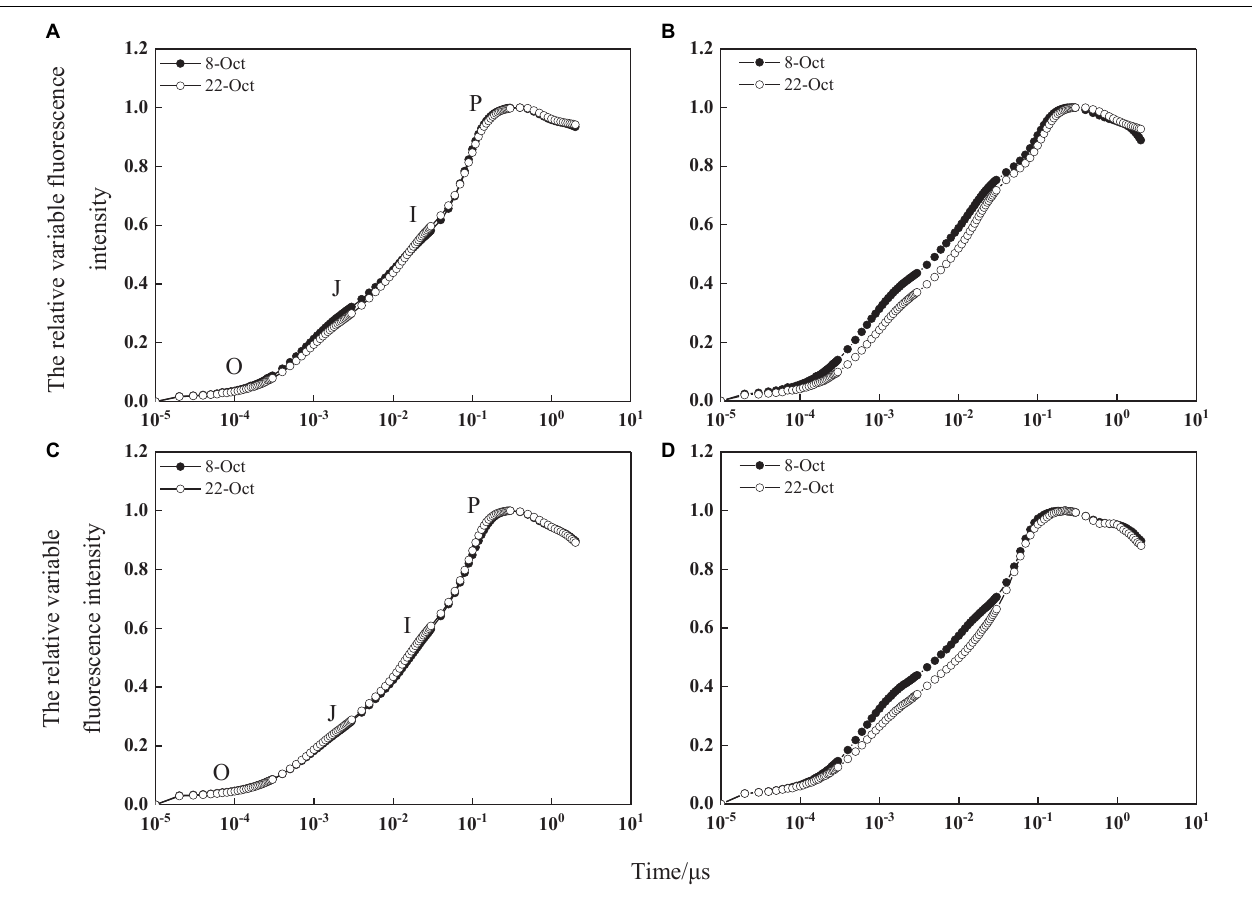
FIGURE 5 | JIP-test curve of relative variable fluorescence intensity before heat stress. (A,C) Are JIP-test curve of relatively variable fluorescence on the third day before heat stress in the 2017–2018 and 2018–2019 growing seasons, respectively. (B,D) Are JIP-test curve of relatively variable fluorescence on the third day after heat stress in the 2017–2018 and 2018–2019 growing seasons, respectively.